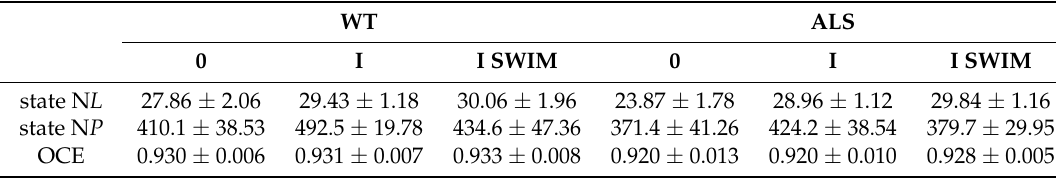
Table 1. Mitochondrial bioenergetics in skeletal muscle of the ALS and WT mice. Non-phosphorylating LEAK respiration (state NL), OXPHOS capacity (state NP) and OXPHOS coupling efficiency (OCE), were measured in skeletal muscle mitochondria. There were no significant differences between the groups. The data are presented as the means ± SEM ( n = 5 in each group). WT ALS